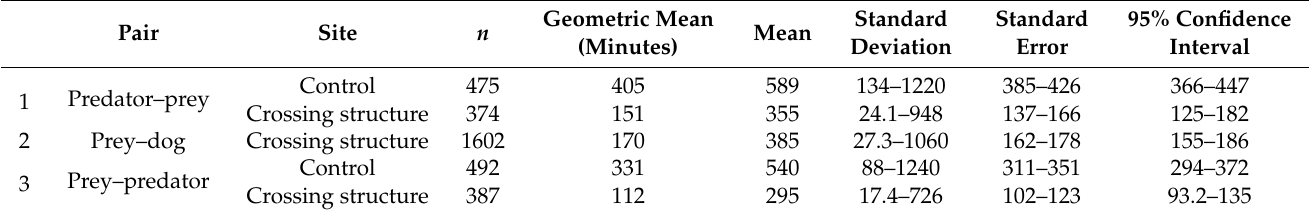
Table 1. Geometric mean latencies (minutes) between predator–prey, prey–dog and prey–predator under crossing structures on NH 44, Pench Tiger Reserve, Maharashtra,